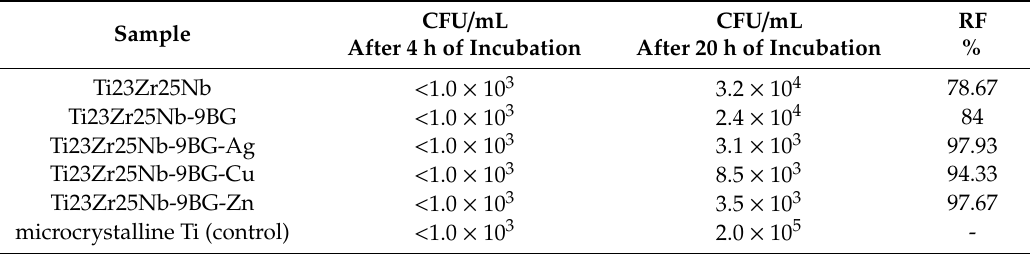
Figure 13. Antibacterial activity against S. mutans ATCC 25175 growth on agar plates from the same dilution after 24 h incubation on different composites: ( a ) Ti23Zr25Nb, ( b ) Ti23Zr25Nb-9BG, ( c ) Table 5. Antibacterial activity of composites against S. mutans ATCC